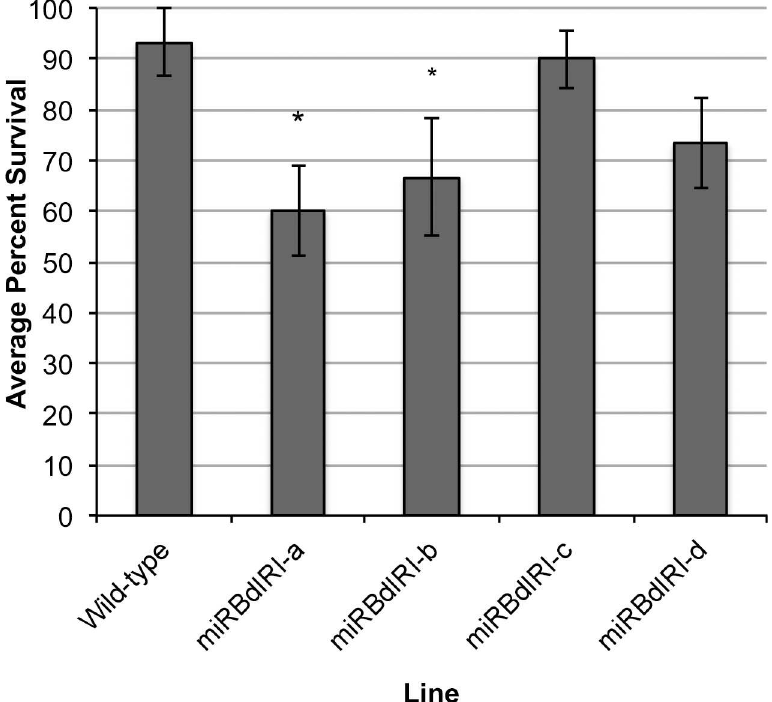
Fig 12. Whole plant freeze survival assaysof wild-type B . distachyon and transgenic knockdown lines (miRBdIRIs). Cold-acclimated wild-typeand knockdown lines (miRBdIRIa-d) were slowly frozen to − 8˚C at a rate of 1˚C/ h. Plants were then allowedto recover for 2 days at 4˚C (no light), and placed back in standardgrowth conditions for 7 days, after which survival was recorded. Valuesare representedas a mean of three trials (n = 10 plants) with error bars representingstandarderror of the mean, and significance denoted by asterisks for p < 0.005(unpairedT-test, one-tailed).